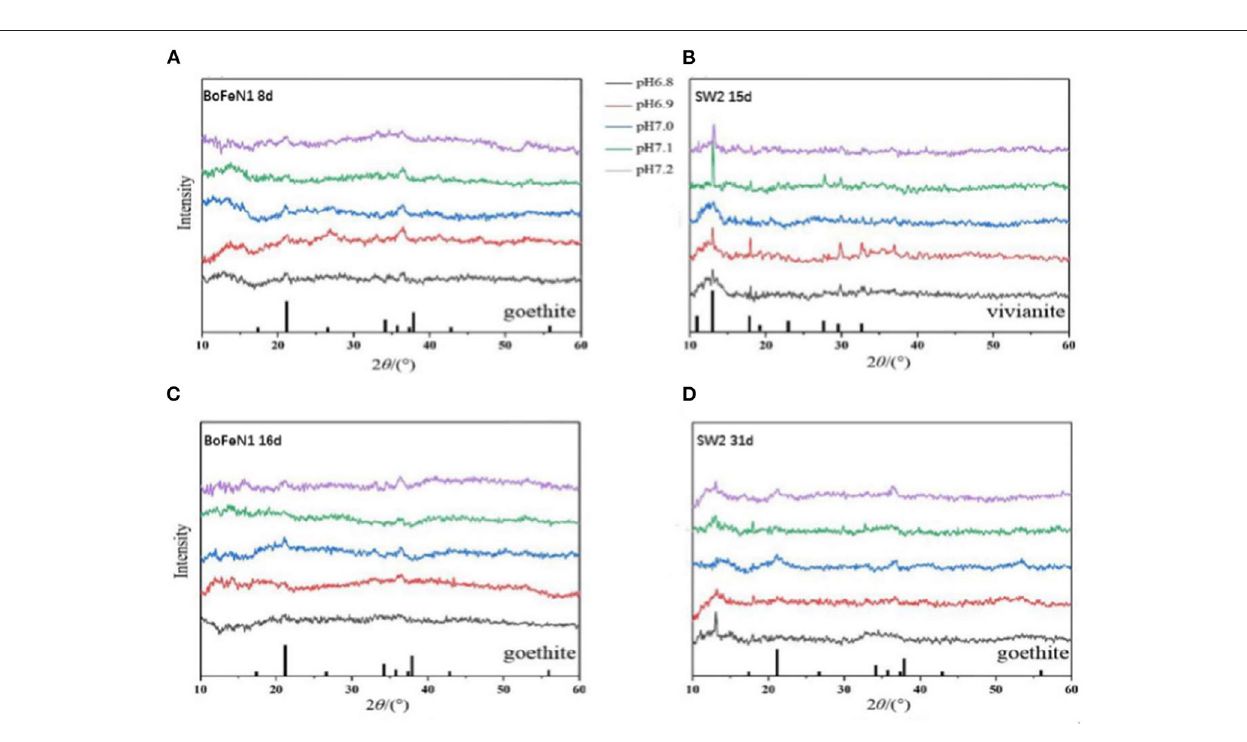
FIGURE 4 | X-ray diffractograms of precipitates collected from (A) 8 days of Acidovorax sp. strain BoFeN1; (B) 15 days of Rhodobacter ferrooxidans strain SW2; (C) 16 days of Acidovorax sp. strain BoFeN1; and (D) 31 days of Rhodobacter ferrooxidans strain SW2. The bottom of (A,C,D) marks the diffraction peak of goethite, and the bottom of (B) marks the diffraction peak of